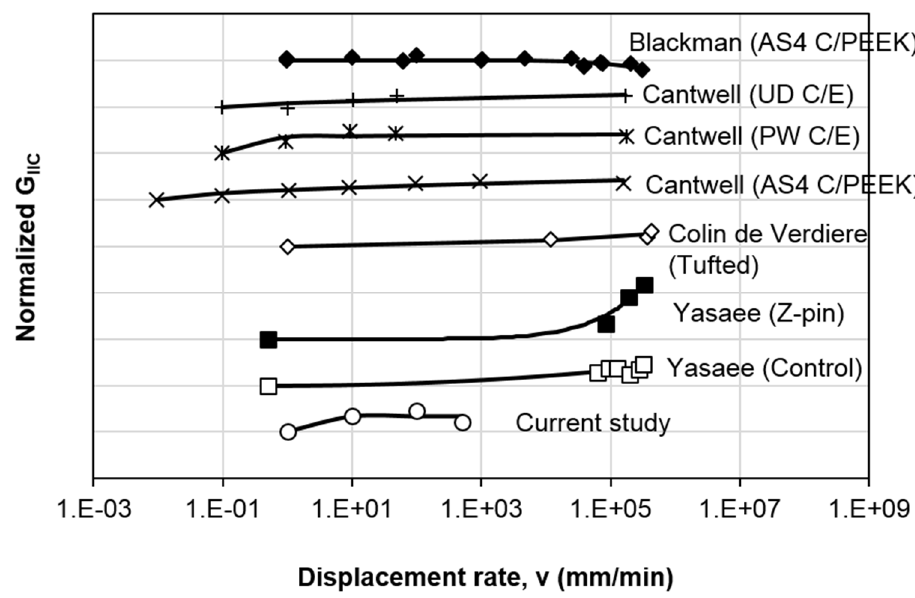
Figure 7. Comparison of the variation of normalized mode II fracture toughness with respect to displacement rate.